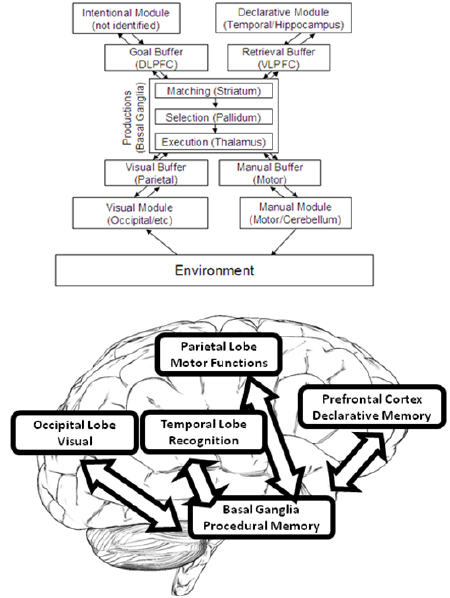
Figure 4. The organization of information in ACT–R (Adaptive Control of Thought–Rational). Adapted with permission from [42].